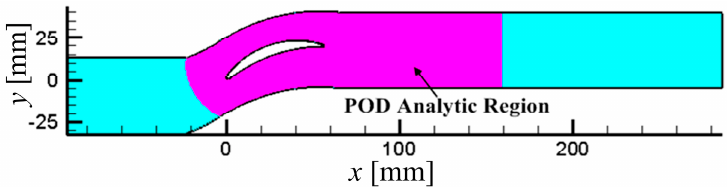
Figure 8. The proper orthogonal decomposition (POD) analytic region of the cascade.